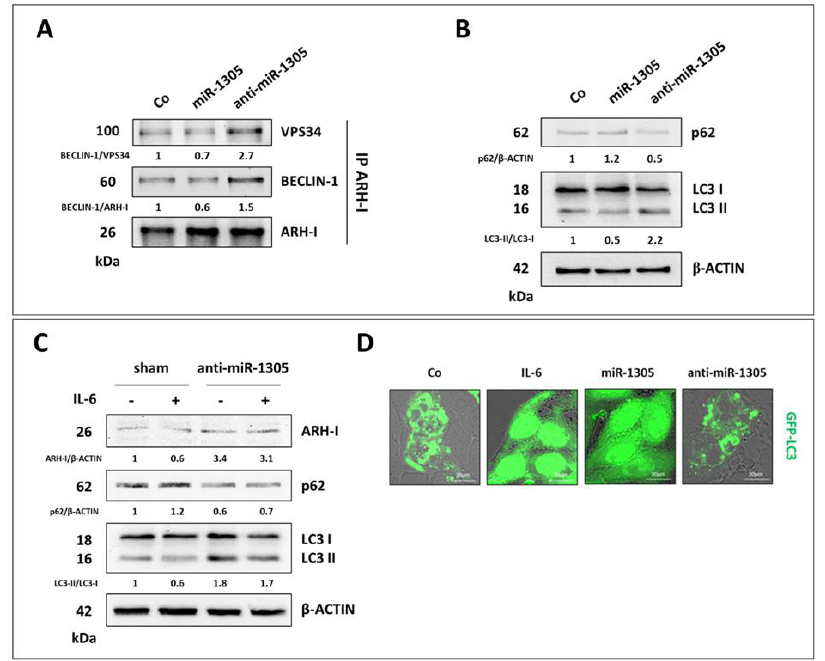
Figure 9. miR-1305 inhibits while anti-miR-1305 induces ARH-I-mediated autophagy. ( A ) The co- immunoprecipitation of ARH-I binding partners of the pro-autophagic interactome. Cells were cul- tured in 2D and transfected with miR-1305 mimic or anti-miR-1305 for 72 h. The quantification of the protein – protein interactions is included. Data are representative of three independent